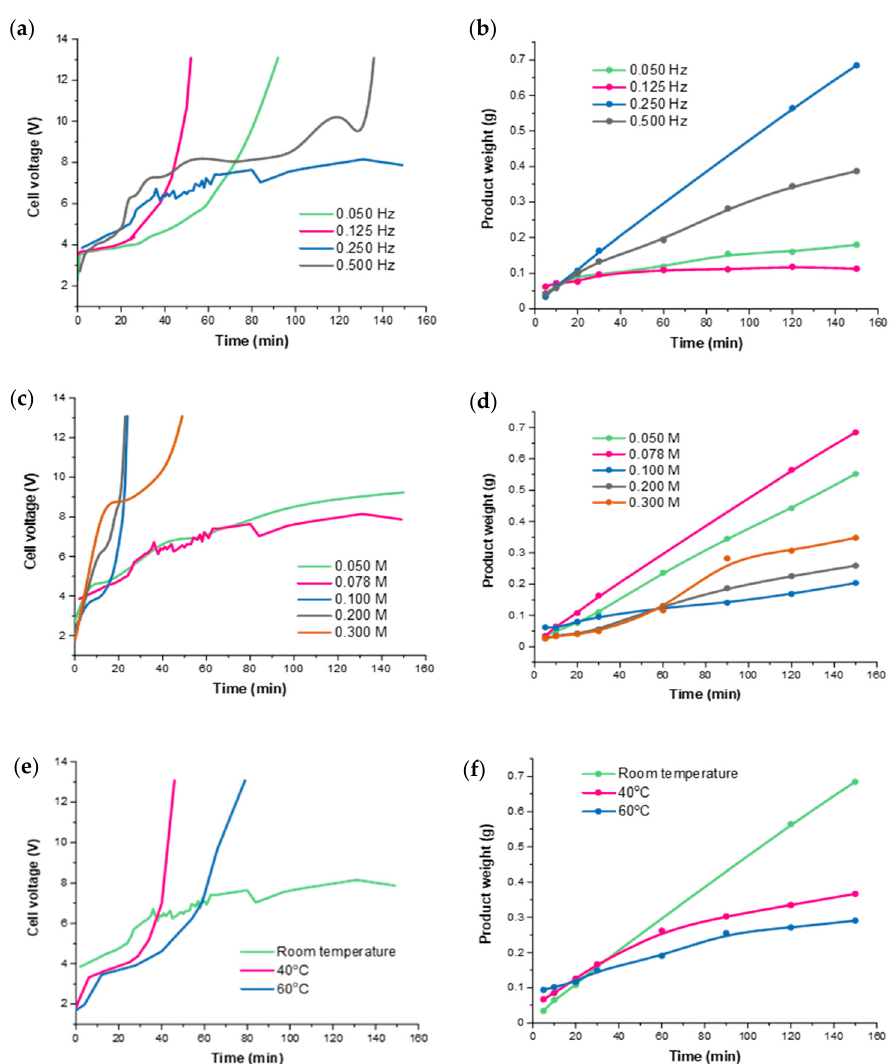
Figure 4. The cell voltage and product mass of the electrosynthesis at various ( a , b ) polarity reversal frequencies, ( c , d ) H 3 BTC concentrations, and ( e , f ) synthesis temperatures. The synthesis parameters were 0.078 M H 3 BTC solution, ambient temperature, and 0.250 Hz polarity reversal frequency except for the parameter that was being studied.